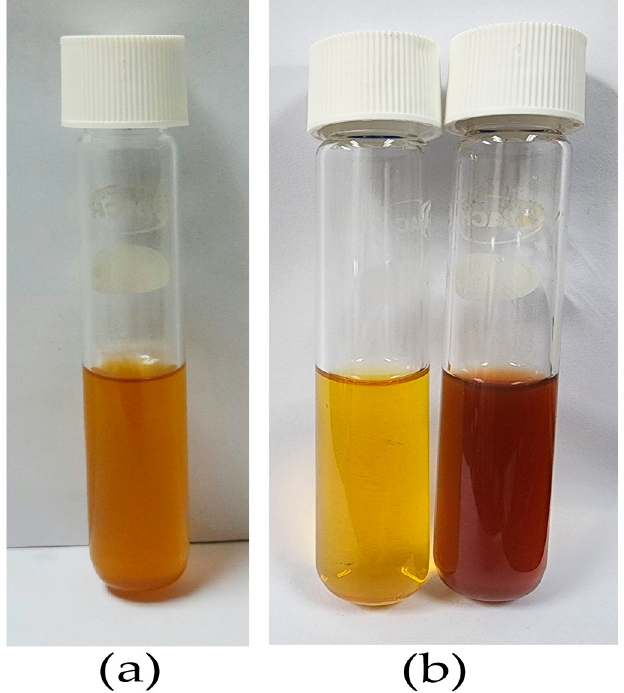
Figure 5. ( a ) Solution of pure G. applanatum extract and ( b ) silver nanoparticles were synthesized under optimal conditions: (left) without G. applanatum extract and (right) with G. applanatum extract.